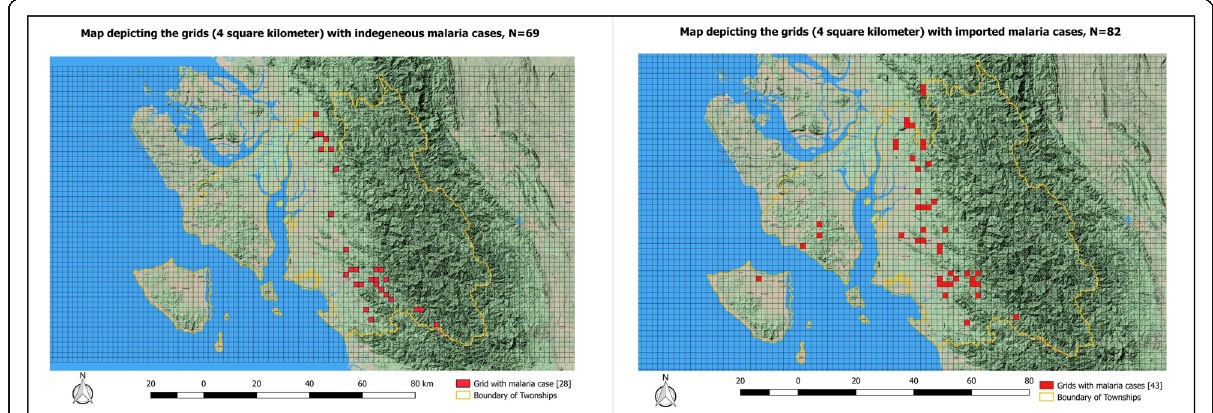
Fig. 4 Maps depicting the equal size grids (4 square kilometre) with at least one indigenous (left) or imported (right) malaria